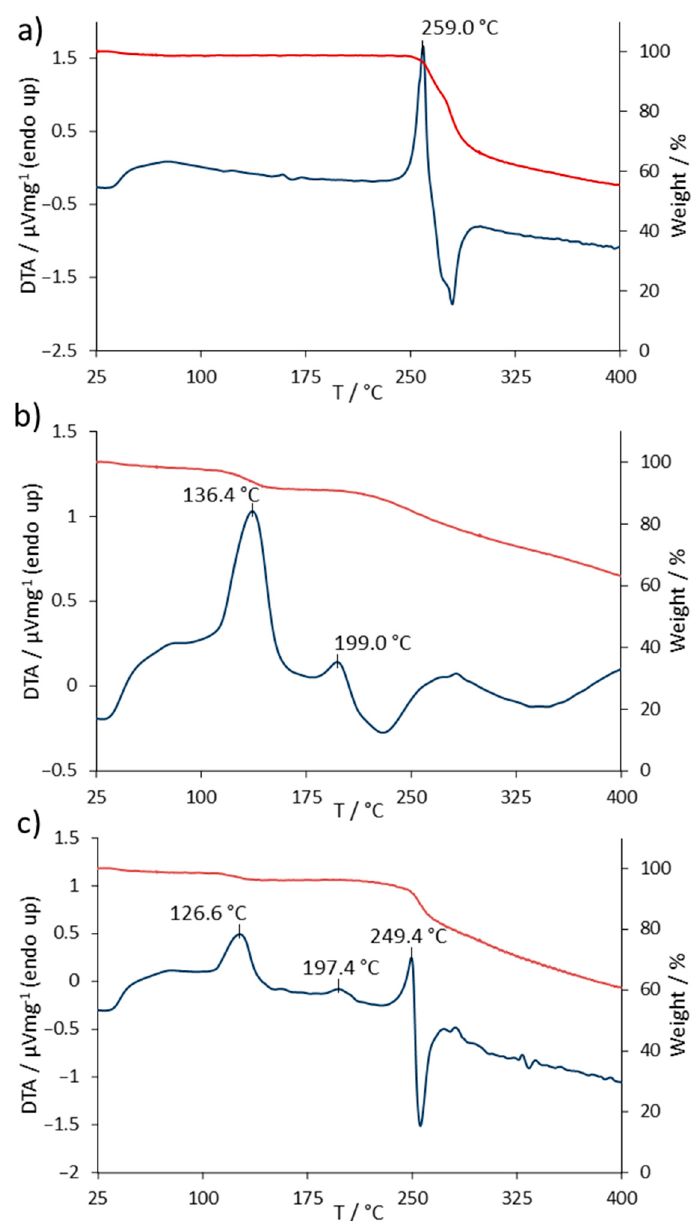
Figure 3. Thermogravimetry (TG) (red line) and differential thermal analysis (DTA) (blue line) curves of ( a ) SASP, ( b ) FA and ( c ) SASP/FA 1:1 blend.